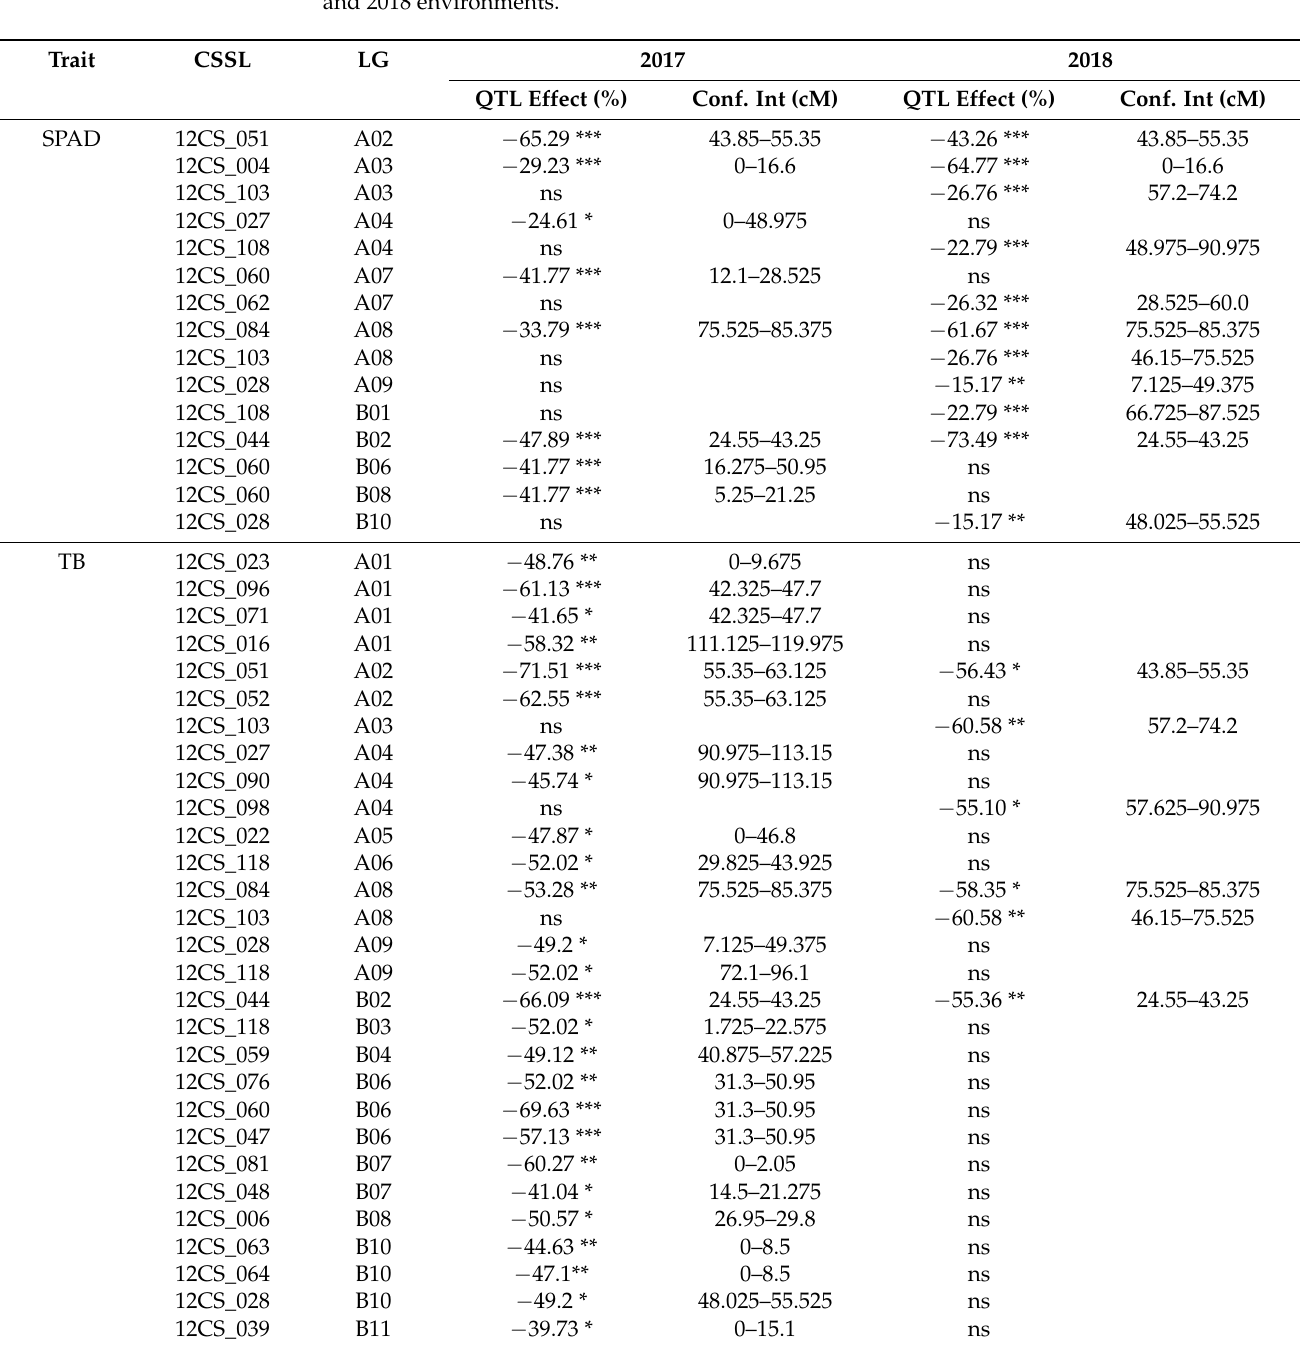
Table 2. Summary of the line × trait significant associations for the inoculated treatment in the 2017 and 2018